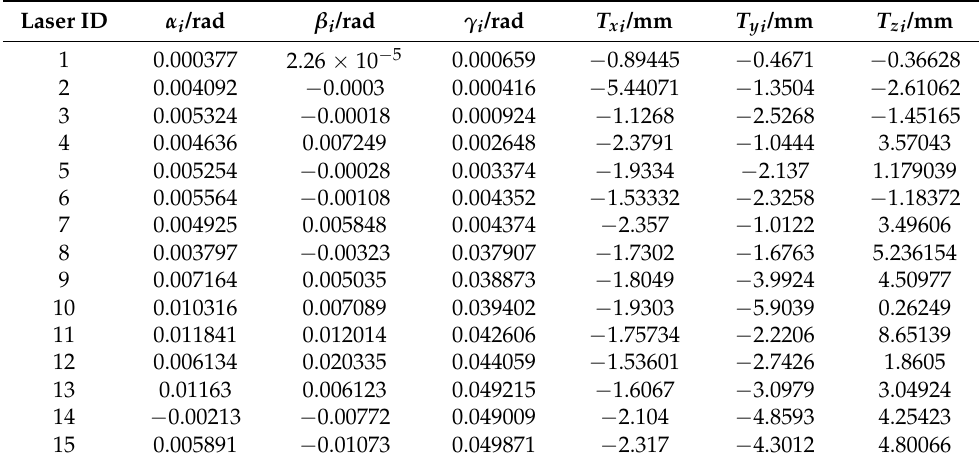
Table 3. Comparison of the point clouds before and after the calibration.